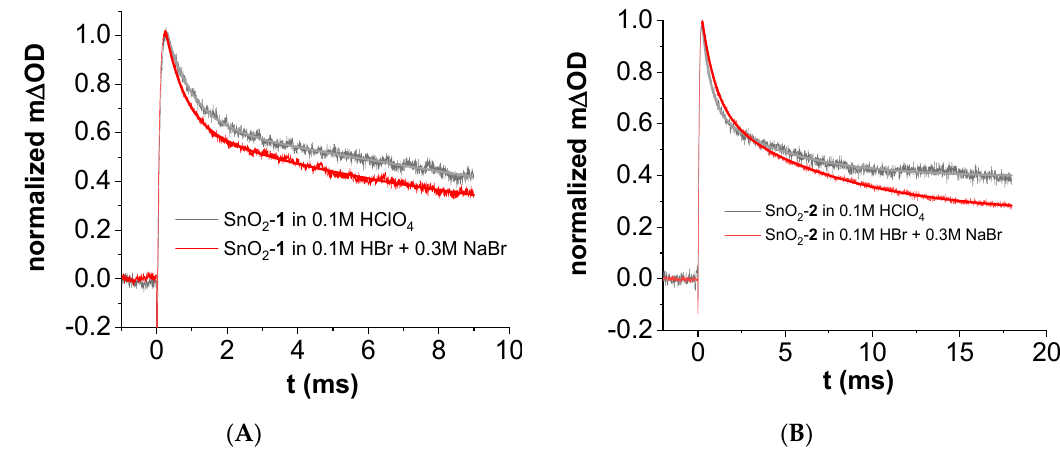
Figure 13. Kinetic evolution of SnO 2 (e − )- 1 (h + ) ( A ) and SnO 2 (e − )- 2 (h + ) ( B ) charge-separated states after the ns laser excitation at 532 nm in 0.1 M HClO 4 (black traces) and 0.1 M HBr + 0.3 M NaBr (red traces) under 0.8 V versus Pt applied bias; 1 M Ω oscilloscope resistance. Traces have been normalized for unity.